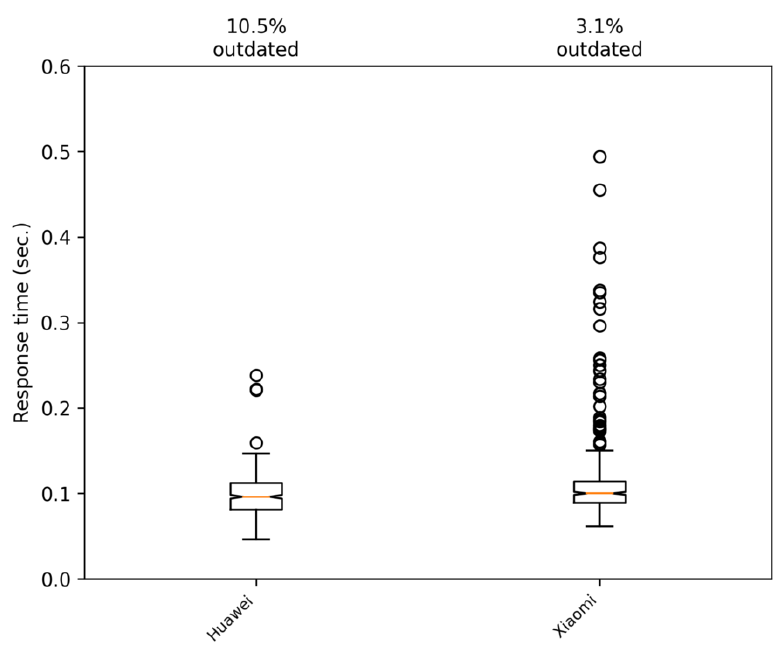
Figure 14. Comparing the two smartphones used in the tests. The data shown correspond to a walking trip.